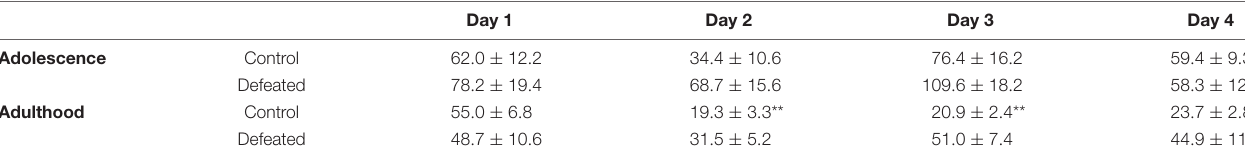
TABLE 1 | Effects of CSD in the acquisition phase of the Barnes maze in both adolescence and